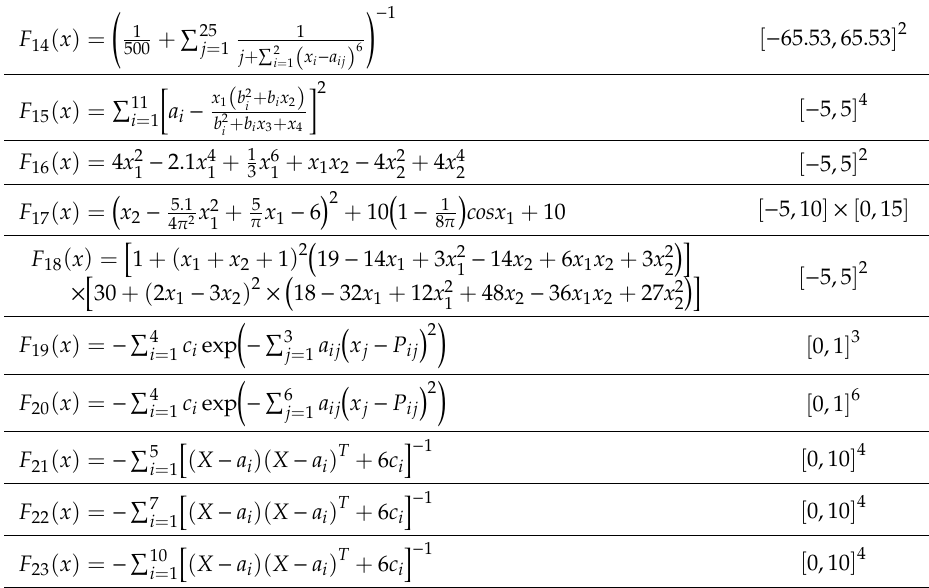
Table A3. Multimodal objective functions with fixed